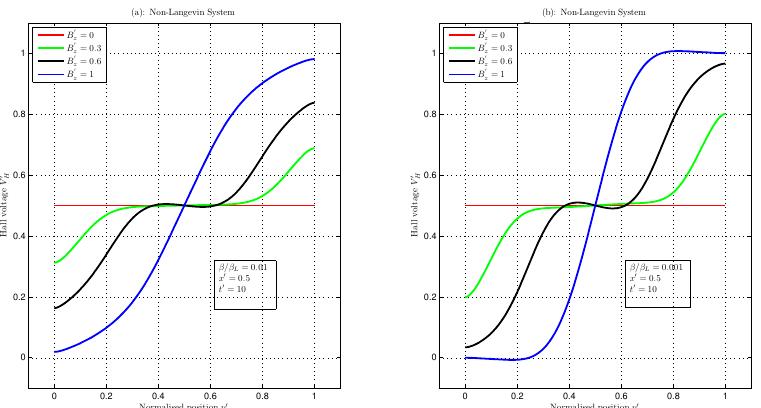
Figure 7. Hall voltage as a function of normalised position for varying magnetic fields in non-Langevin system with ( a ) β